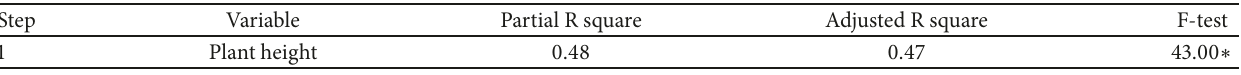
Table 7: Stepwise regression analysis of the 7 evaluated traits.